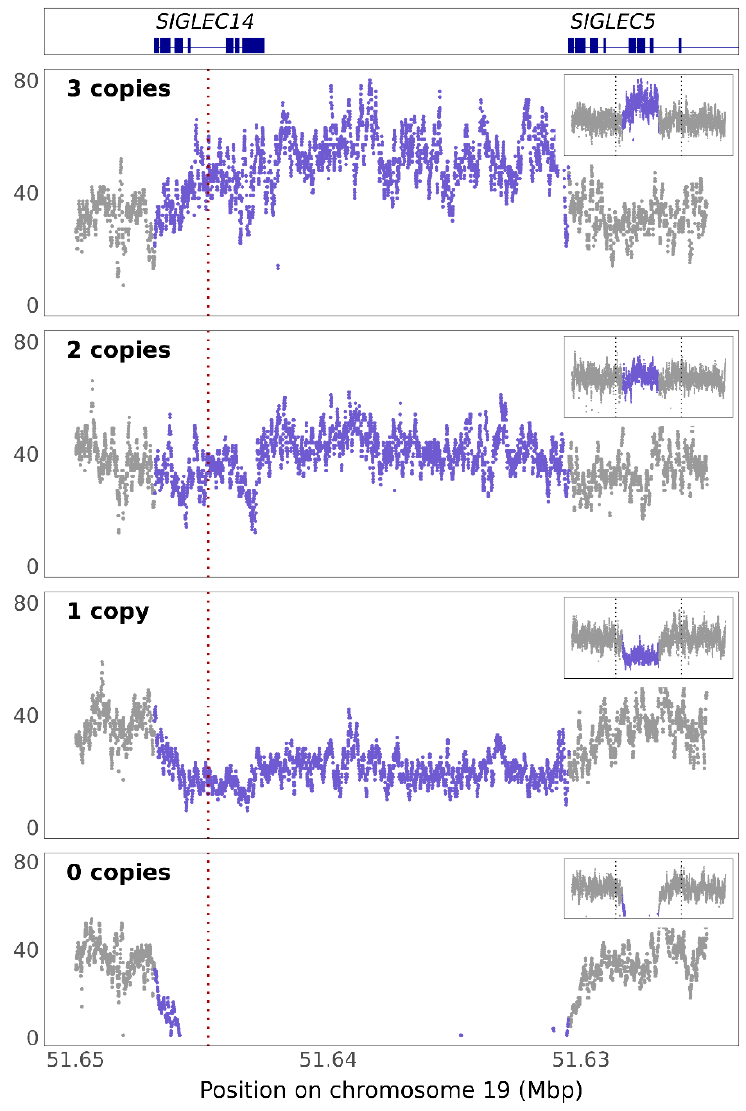
Figure 2. SIGLEC14 CNVs detected in ADNI and ADSP cohorts. Read depth shown by chromosomal position of whole-genome sequencing in a representative example of each CNV detected. Exon/intron maps for SIGLEC14 and SIGLEC5 at figure top for reference. Purple: copy number variation. Inset: expanded view of locus. Red dotted line: location of copy number variation assay. The dotted line in the insets shows the boundaries of the full-size image. Table 4. Summary of the SIGLEC14 CNV in the 3095 sample ADSP WGS dataset.